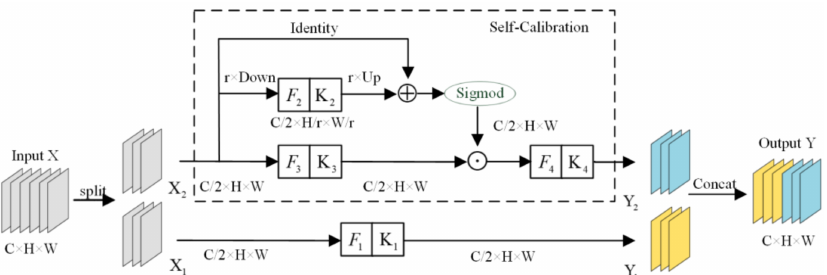
Figure 7. Schematic illustration of the self-calibrated convolutions. The original filter is separated into four parts, each responsible for different functions. The plus sign in the figure is element-wise summation. The dots in the figure are element-wise